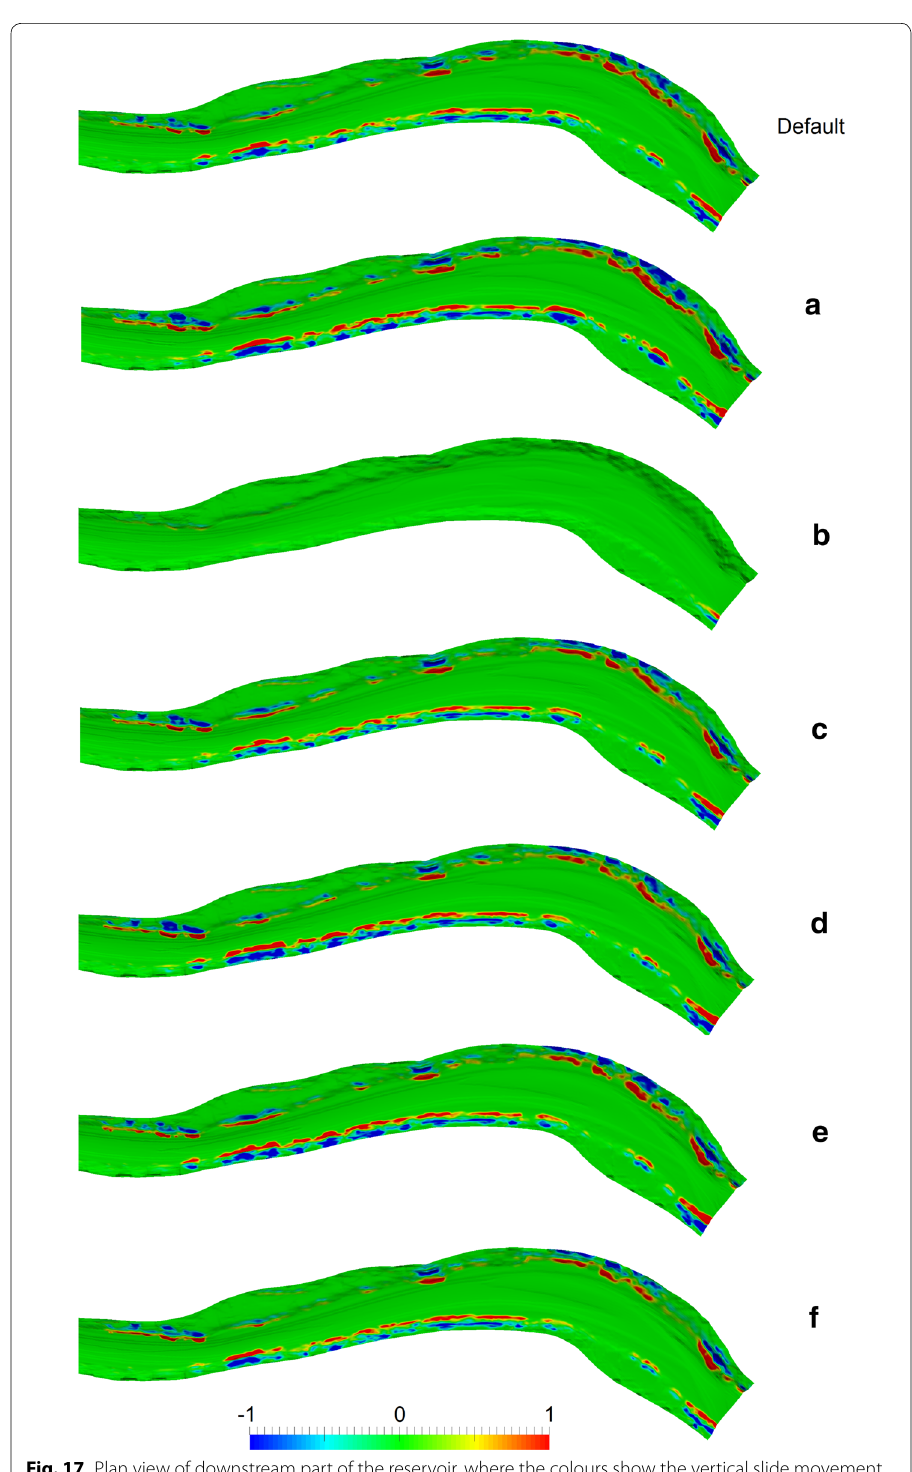
Fig. 17 Plan view of downstream part of the reservoir, where the colours show the vertical slide movement [meters]. The letters indicate results with various parameter changes, as given in Table